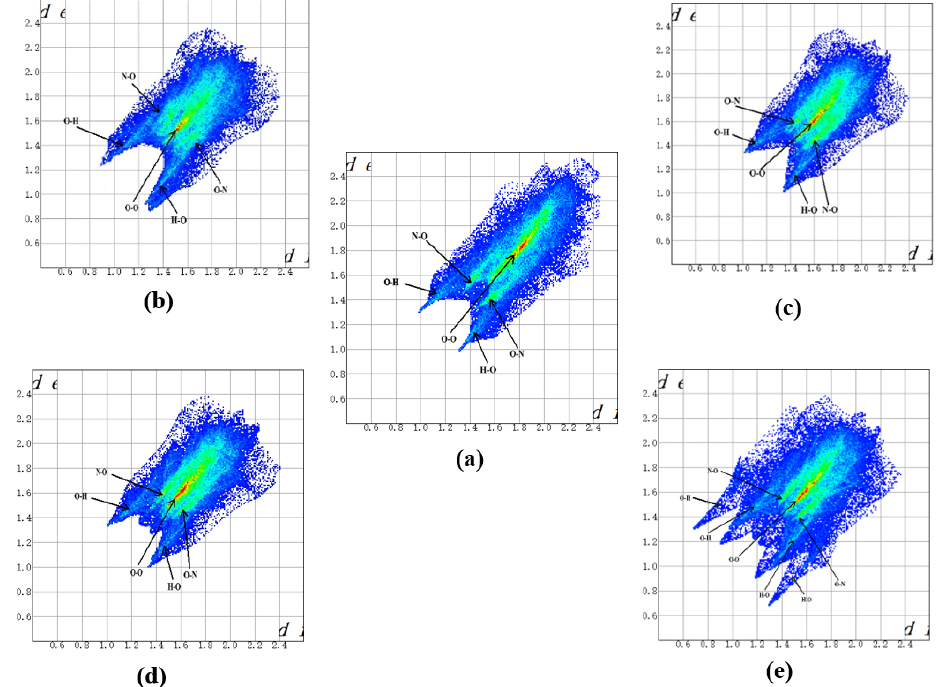
Figure 5. Two-dimensional fingerprint plots of close interatomic contacts of CL-20 molecules in pure form and in four host–guest complexes: ( a ) CL-20, ( b ) CL-20/H 2 O 2 , ( c ) CL-20/CO 2 , ( d ) CL-20/N 2 O, and ( e ) CL-20/H 2 O.